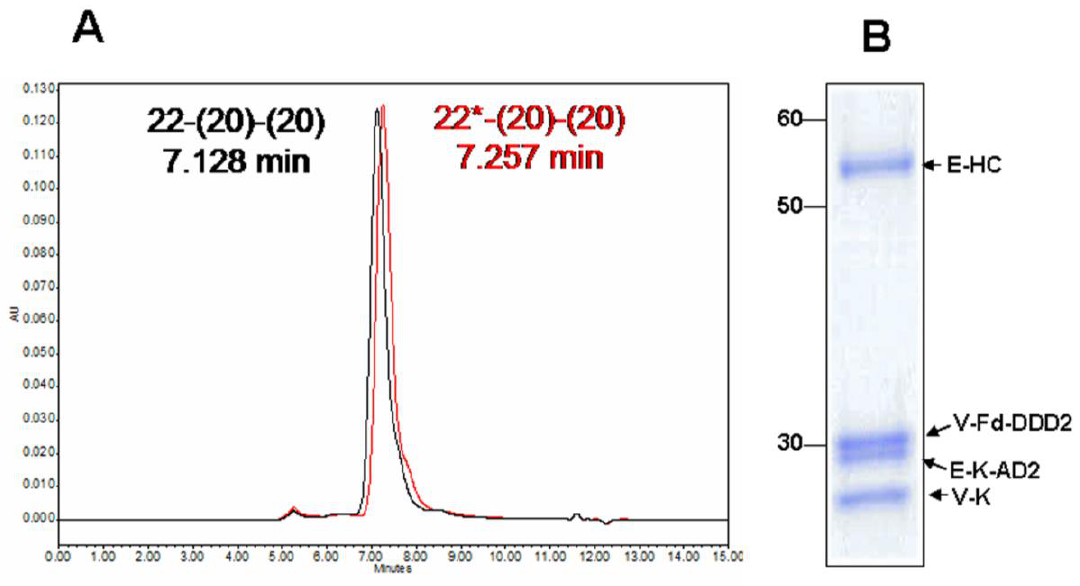
Figure 3. SE-HPLC profile ( A ) and SDS-PAGE analysis ( B ) of 22*-(20)-(20). Adapted from Reference